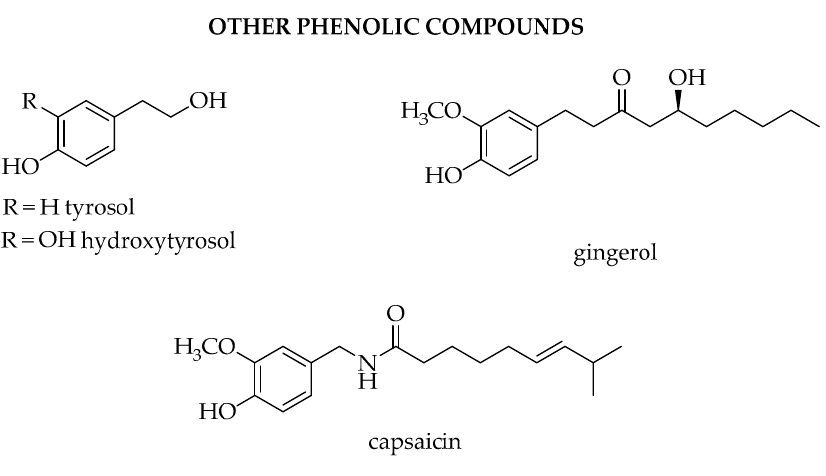
Figure 4. Other phenolic compounds.